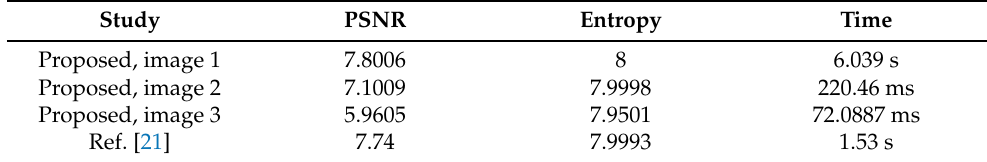
Table 6. Comparison With Other